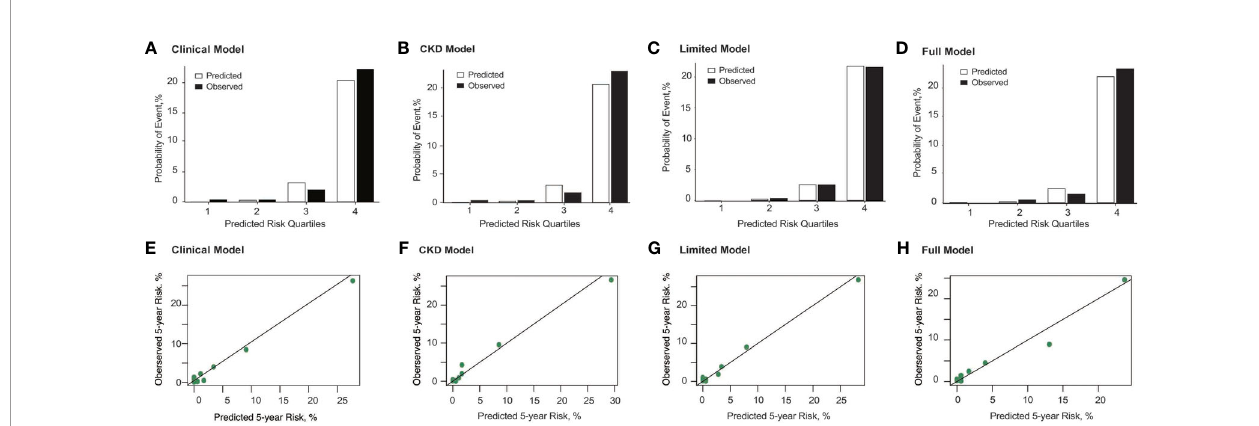
FIGURE 2 | Observed vs . predicted probability and calibration curve of ESRD at 5 years using the Clinical Model (A, E) , CKD Model (B, F) , Limited Model (C, G) , and Full Model (D, H) . The predicted and observed event probability estimates represent the mean predicted probability from risk-prediction model and the mean observed probability from the population divided into quartiles of predicted probability. For those models, risk groups were based on the 16th (lowest risk), 16th to 50th (intermediate risk), 50th to 84th (higher risk), and higher than 84th (highest risk) percentiles of the linear predictor. The mean predicted probability (%) vs . observed probability (%) categories for quartiles 1 through 4 correspond with 0.02% vs . 0.35%, 0.25% vs . 0.33%, 3.14% vs . 2.00%, and 20.36% vs . 22.26%, respectively, for the Clinical Model; 0.03% vs . 0.35%, 0.24% vs . 0.33%, 3.01% vs . 1.67%, and 20.65% vs . 22.97%, respectively, for the CKD Model; 0.03% vs . 0.00%, 0.21% vs . 0.33%, 2.53% vs . 2.50%, and 21.74% vs . 21.55%, respectively, for the Limited Model; and 0.03% vs . 0.00%, 0.22% vs . 0.50%, 2.42% vs . 1.50%, and 21.95% vs . 23.32%, respectively, for the Full Model. In addition, the Hosmer – Lemeshow test presented that the full model with race had p value > 0.05, which means the goodness of model fi t is